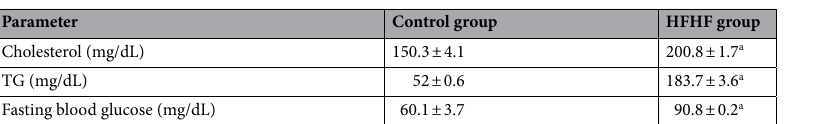
Table 1. Preliminary biochemical investigations after 4 weeks of HFHF diet. Data are presented as mean ± SD values and are representative of a single independent experiment ( n = 4). Statistical analysis was performed using an unpaired t-test. a Significantly different from the control group. Differences were considered significant if the p-value was < 0.05. HFHF high-fat high-fructose diet, TG triglycerides.